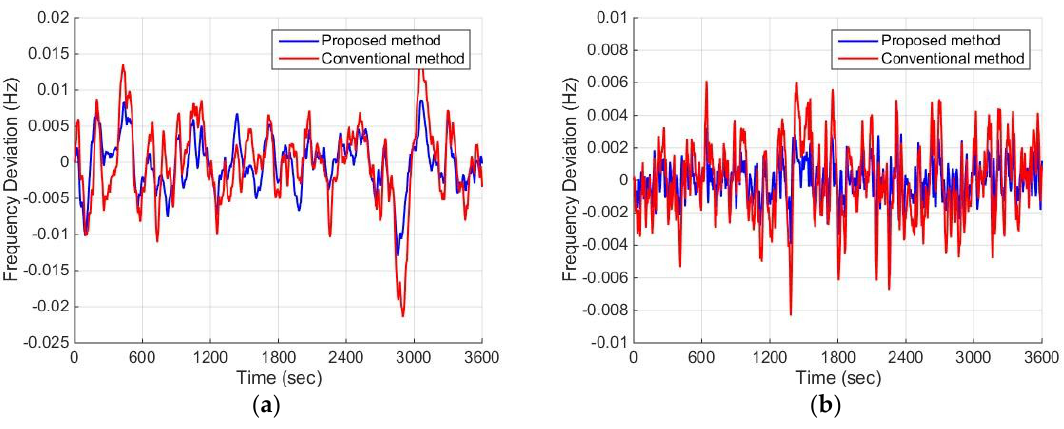
Figure 10. Frequency deviation without disturbance or uncertainties: ( a ) MG 2 ; ( b ) MG 3